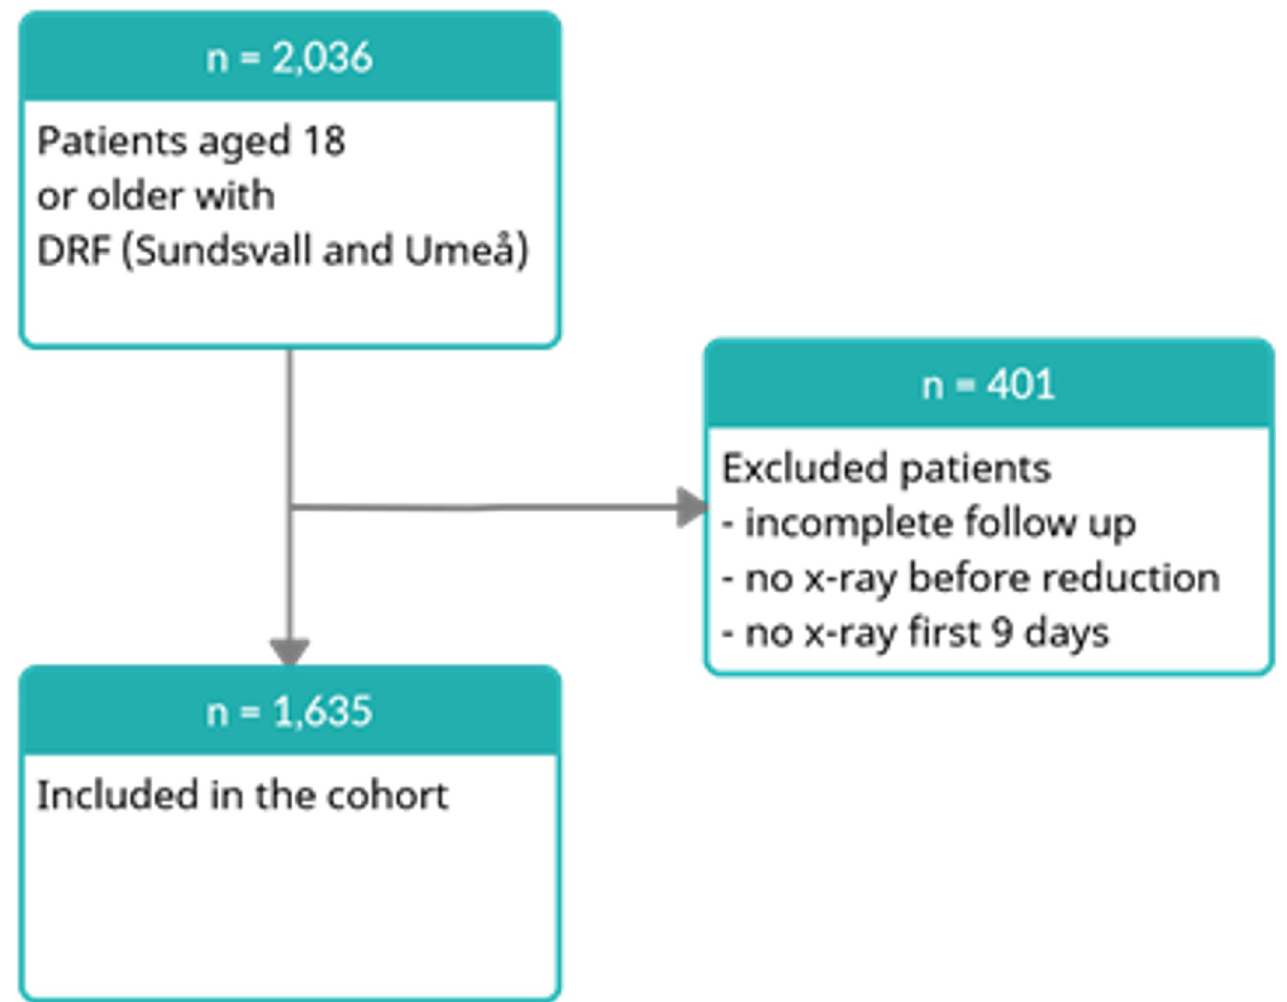
Fig 1. Flowchart of patient inclusion and exclusion in a retrospective cohort study of 1,635 distal radius fractures (DRF) in two hospitals in Sweden in